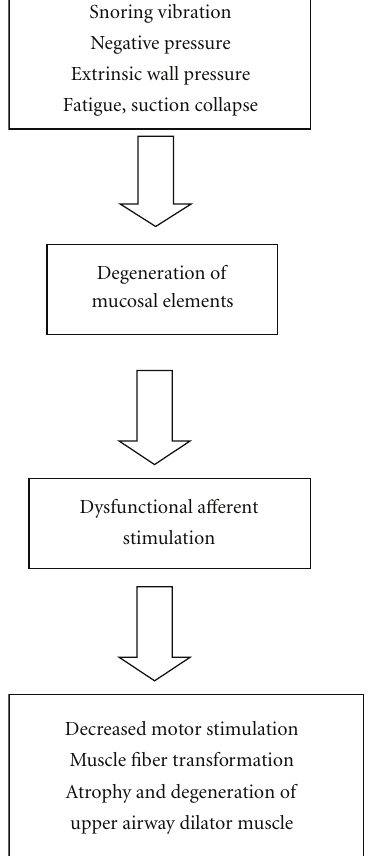
Figure 1: Schematic representation of dysfunctional a ff erent input from the periphery and consequent deleterious impact on e ff erent motor limb of the input-output reflex to upper airway dilator muscles, including pharynx, genioglossus, and tensor